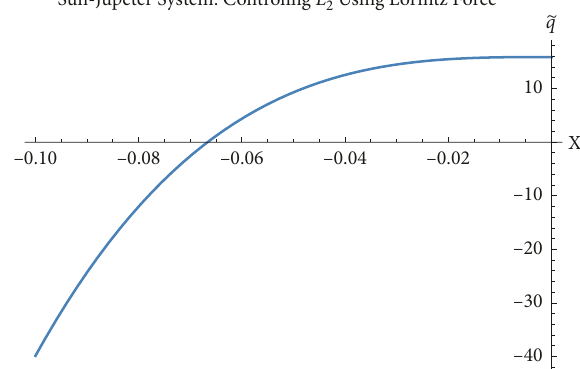
Figure 5: Specific charge to generate artificial liberation points � − 0 . 06667522806903911. about L 2